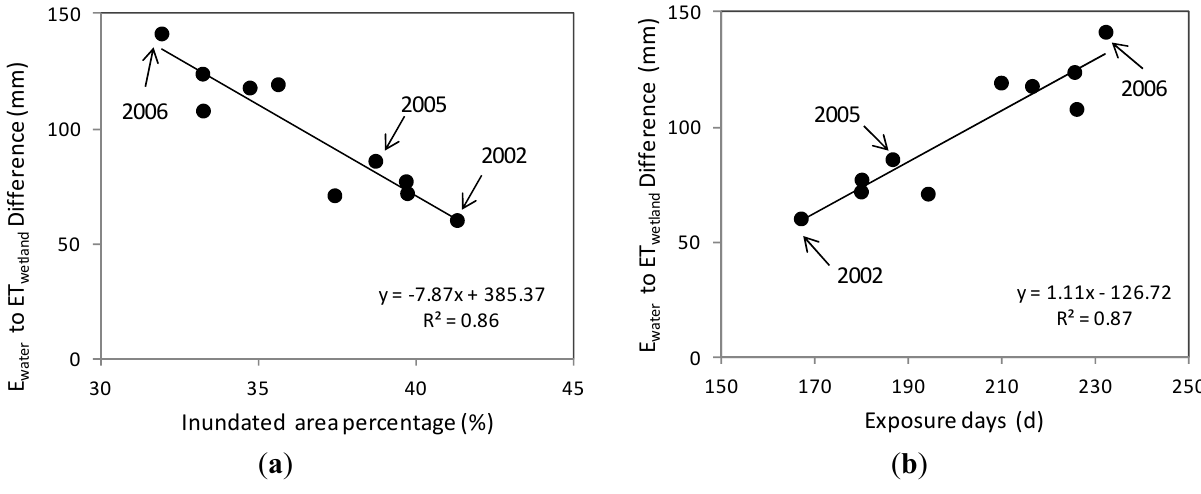
Figure 8. Relationship of annual E inundated area and ( b ) exposure days for 2000–2009 for the Poyang Lake